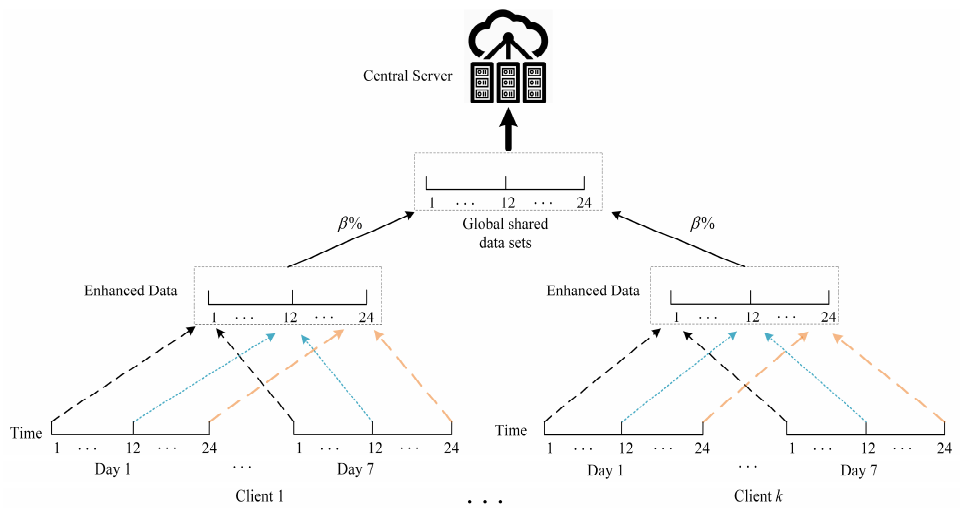
Figure 3. Enhanced data strategy.